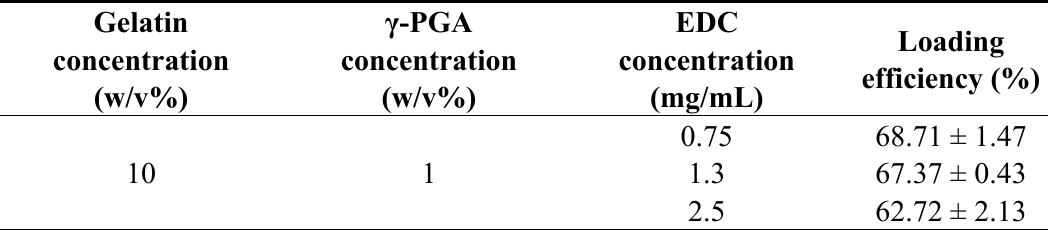
Table 1. The effect of the crosslinker on the loading efficiency of